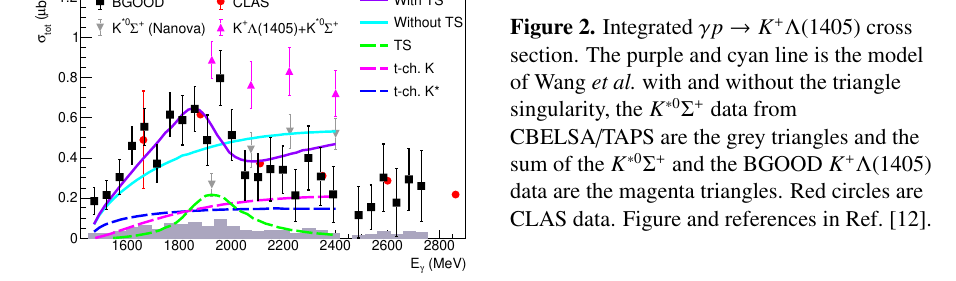
Figure 2. Integrated γ p → K + Λ (1405) cross section. The purple and cyan line is the model of Wang et al. with and without the triangle singularity, the K ∗ 0 Σ + data from CBELSA / TAPS are the grey triangles and the sum of the K ∗ 0 Σ + and the BGOOD K + Λ (1405) data are the magenta triangles. Red circles are CLAS data. Figure and references in Ref. [12].